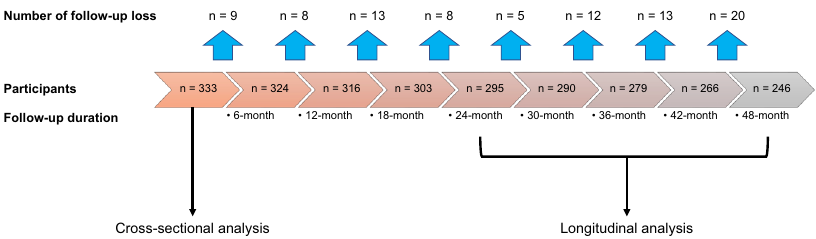
Fig. 5 Attrition rate in the cohort. In this study, 333 patients were enrolled in the cross-sectional analysis, and 295 patients who were followed-up more than 2 years were enrolled in the longitudinal